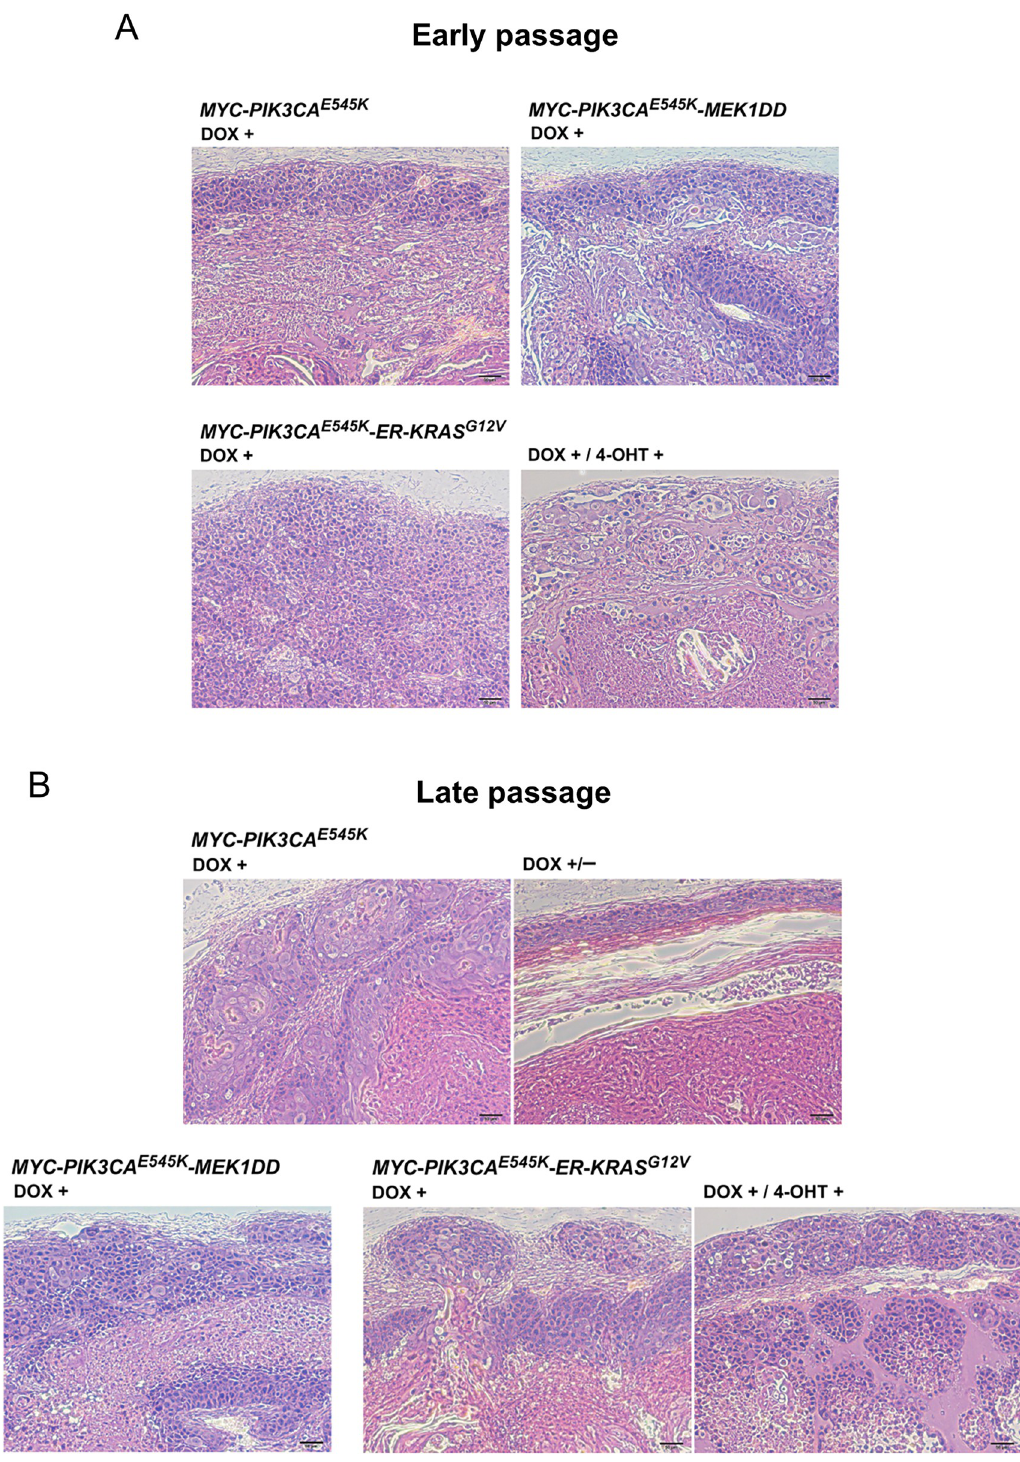
Fig 5. H&E staining of tumor tissues. H&E staining of representative tumors isolated from nude mice injected with HCK1T/ 16epi expressing MYC/PIK3CA E545K alone or with MEK1DD and/or ER-KRAS G12V , at early passage ( A ) and at late passage ( B ). Scale bars represent 50 μ